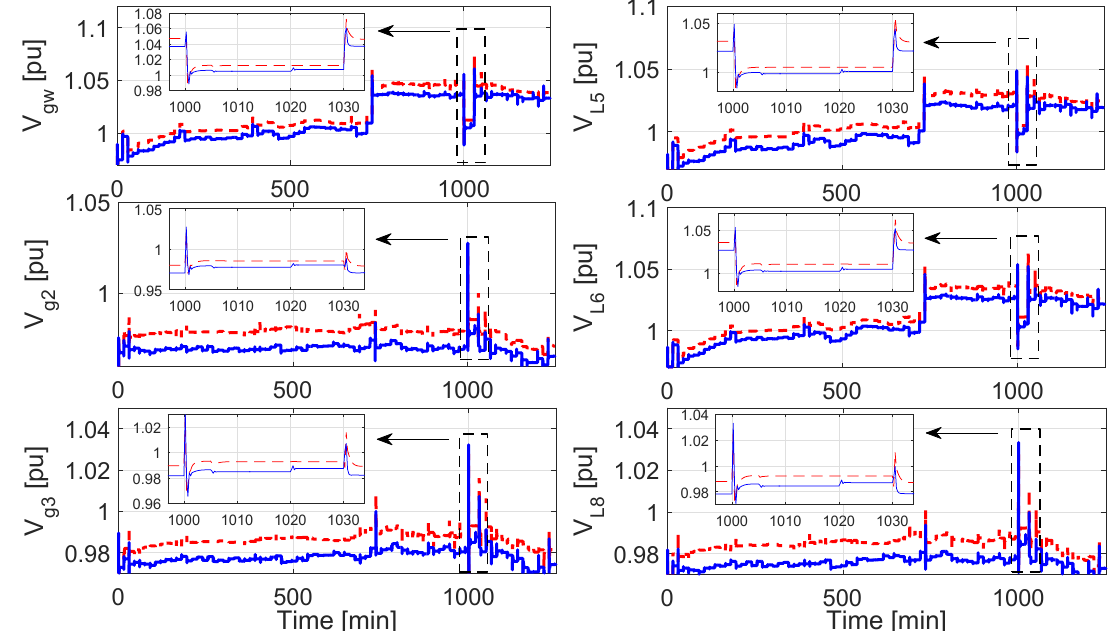
Figure 3. Voltages in the main nodes of the power system under unexpected reduction of the wind power. Proposed robust EMS (solid blue line). EMS with perfect prediction (dash red line).